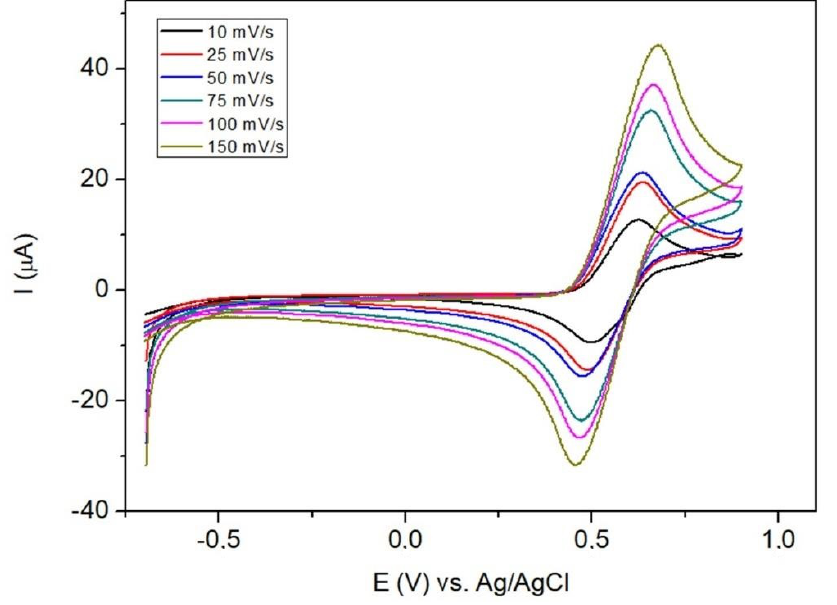
Figure 18. CVs in 0.12 mM ABTS · + in a 1:1 water/methanol mixture with 0.05 M KCl recorded at several scan rates.